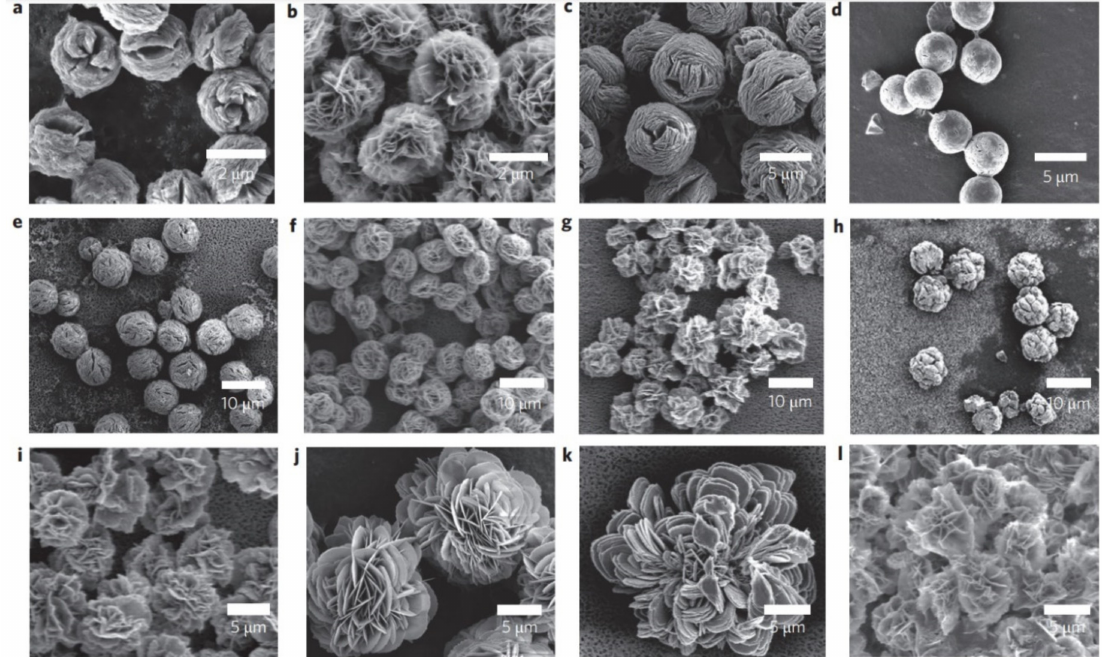
Figure 8. SEM images of hybrid nanoflowers: ( a – l ) column 1, a-lactalbumin; column 2, laccase; column 3, carbonic anhydrase; column 4, lipase; at protein. Reprinted from [20] with permission from Springer Nature. Copyright © 2021, Nature Publishing Group. License Number: